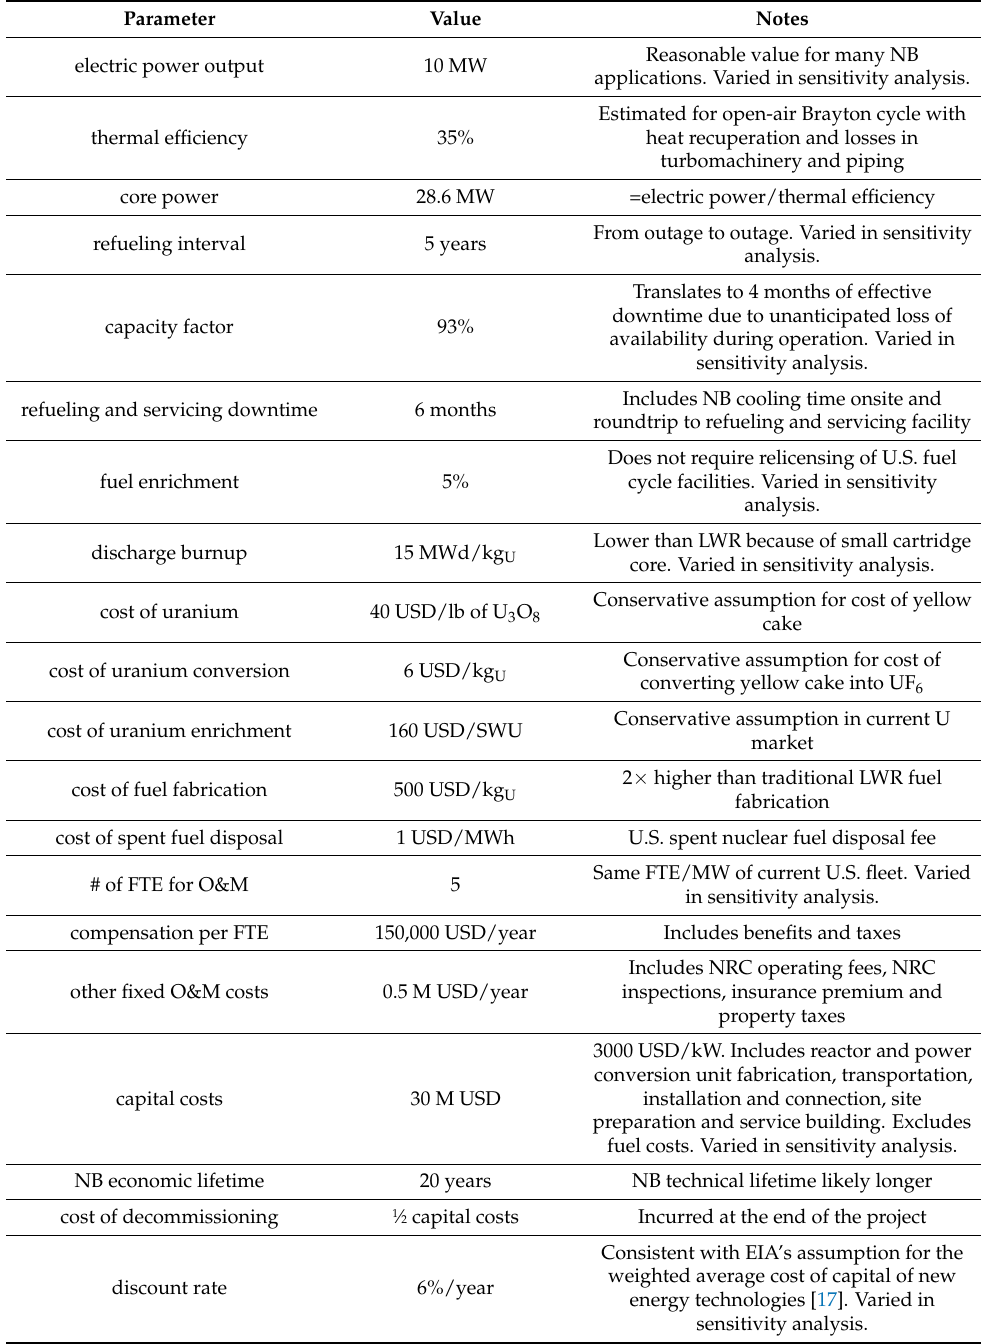
Table 3. Baseline assumptions for the NB cost